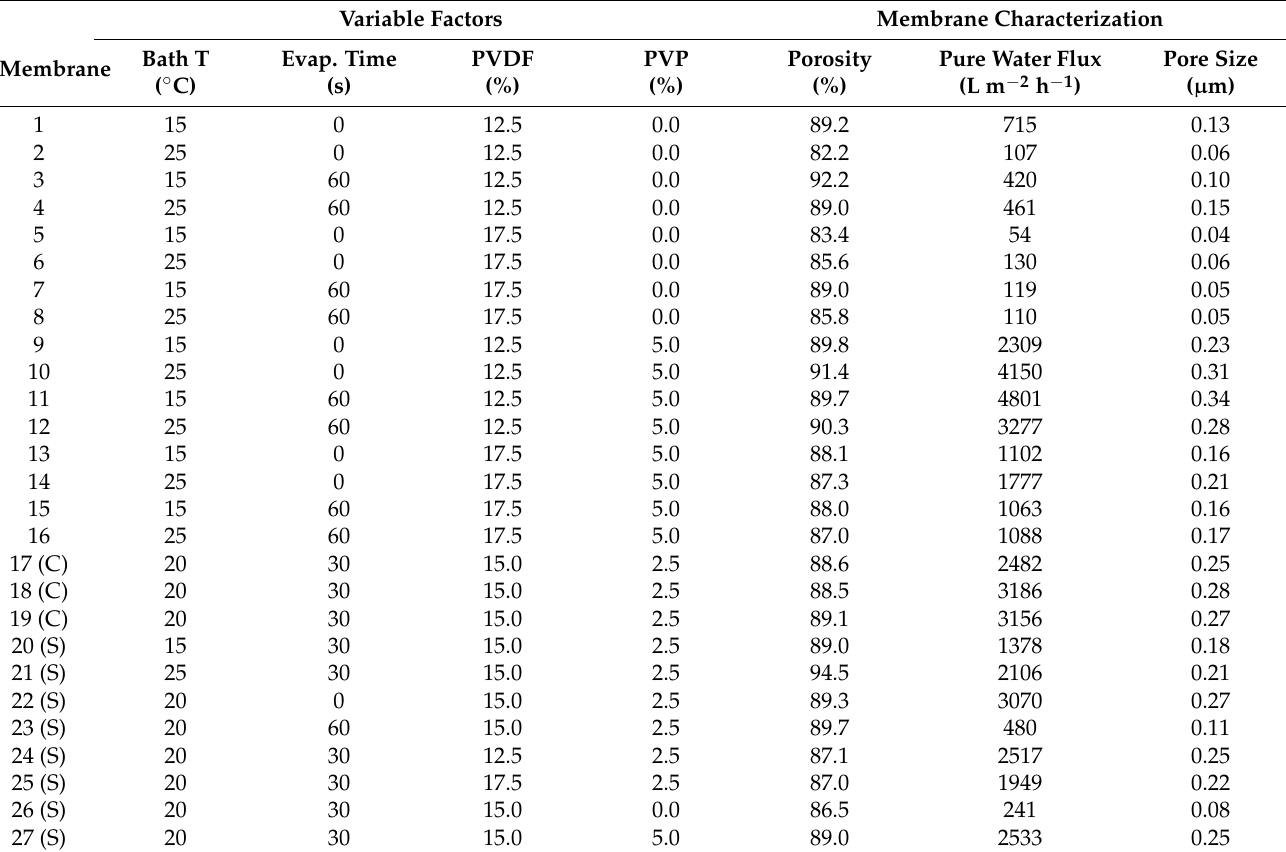
Table 3. Fabrication conditions according to the central composite design and characterization